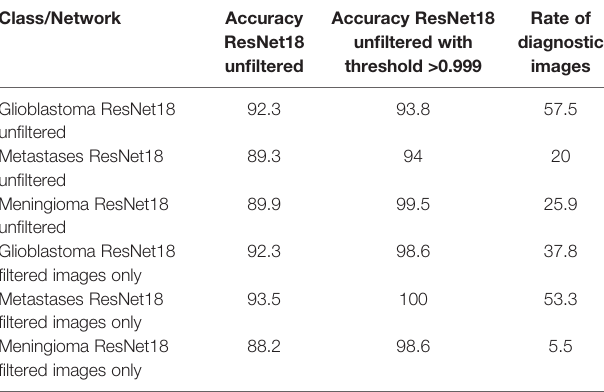
TABLE 3 | Accuracy analysis of residual neural network with multiclass classi fi cation for individual